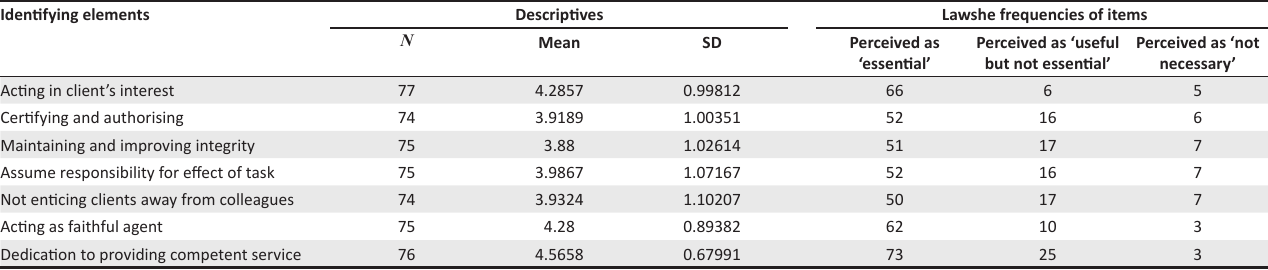
TABLE 9: Descriptive statistics of responsibility towards client or employer.